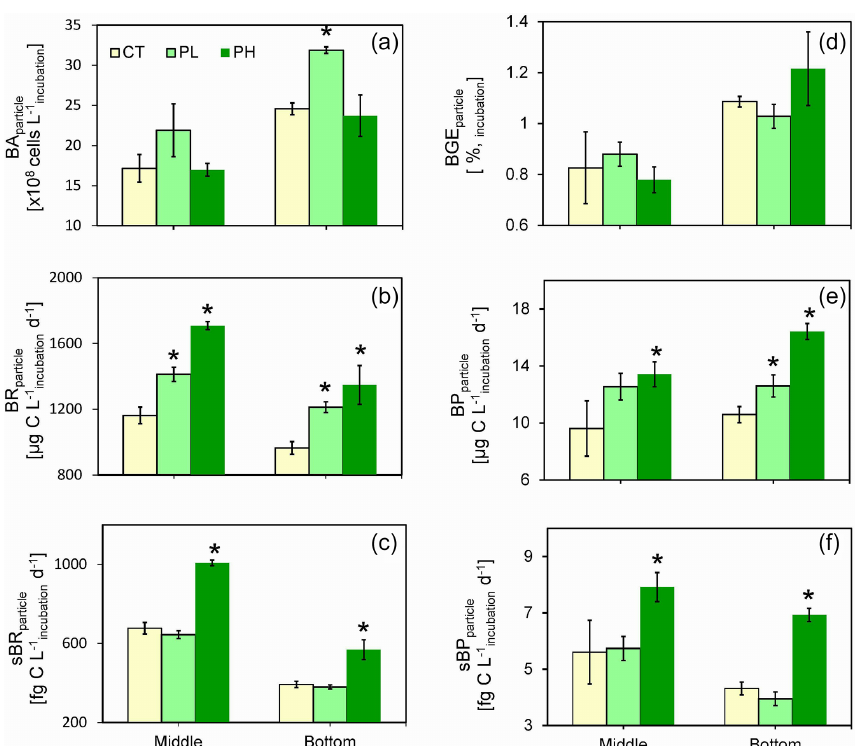
Figure 7. Responses of particle-attached bacterial parameters including (a) bacterial abundance (BA particle ), (b) bacterial respiration (BR particle ), (c) cell-specific bacterial respiration (sBR particle ), (d) bacterial growth efficiency (BGE particle ), (e) bacterial production (BP particle ), and (f) cell-specific bacterial production (sBP particle ) to different doses of PUA additions at the end of the experiments for the middle (12m) and the bottom waters (25m) at station Y1. Error bars are standard deviations. The star represents a significant difference ( p < 0 . 05), with PL and PH the low- and high-dose PUA treatments and C the control.